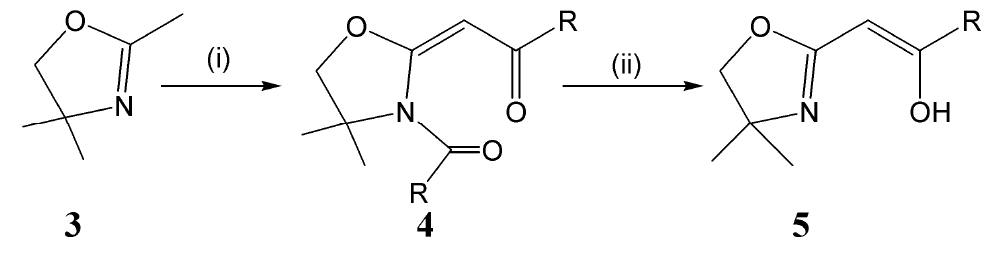
) in the presence of two equiv. of a benzoyl- or 3 H OCH - p ( i.e ., 4 : derived from 4-anisic acid). 6 4 3 H -C(=O)Cl / NEt / MeCN / ∆ 6 4 3